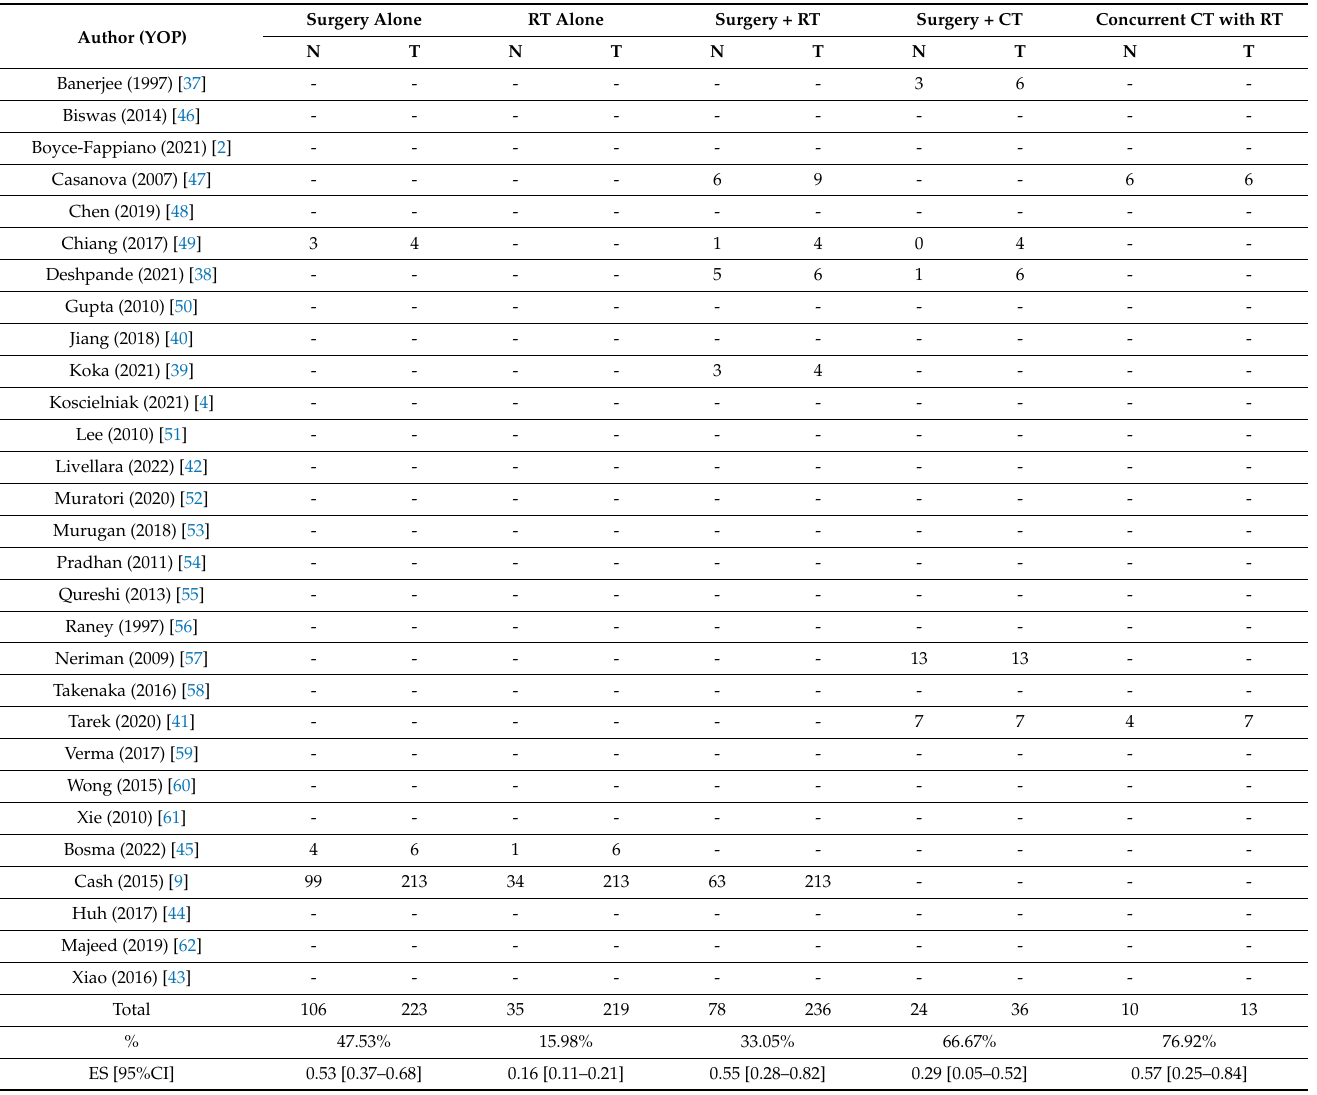
Table 4. Trends in the management modalities of pediatric cases of extraosseous Ewing sarcoma reported in the